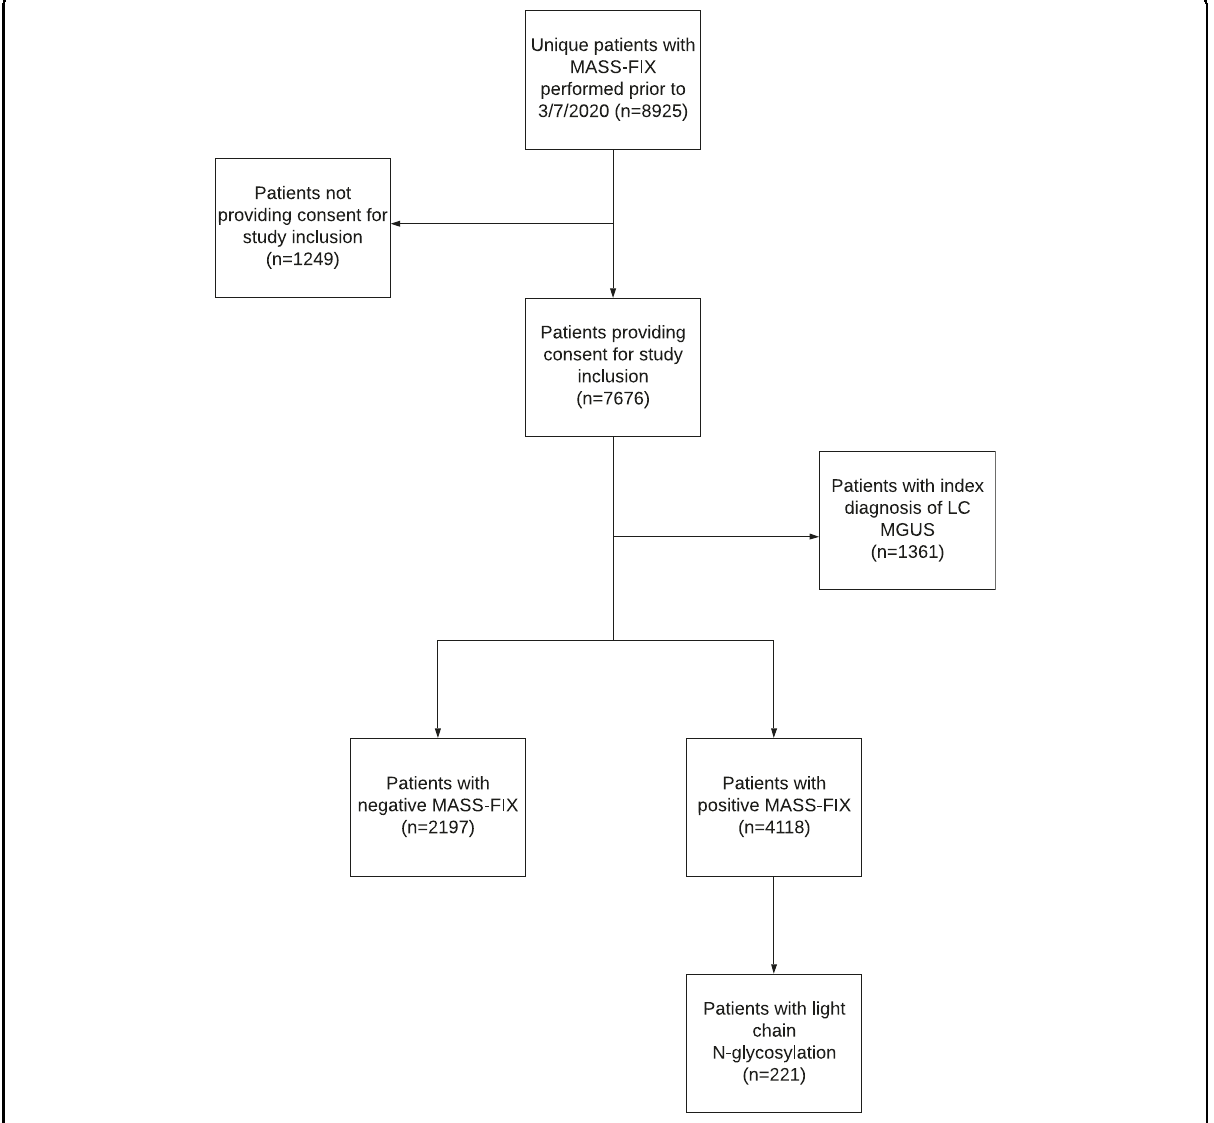
Fig. 1 Consort diagram. Illustrating inclusion and exclusion criteria for 4118 MASS-FIX positive and 2197 MASS-FIX negative patients with MASS-FIX performed at Mayo Clinic from 7/24/2018 to 3/7/2020; LC MGUS light chain monoclonal gammopathy of undetermined signi fi